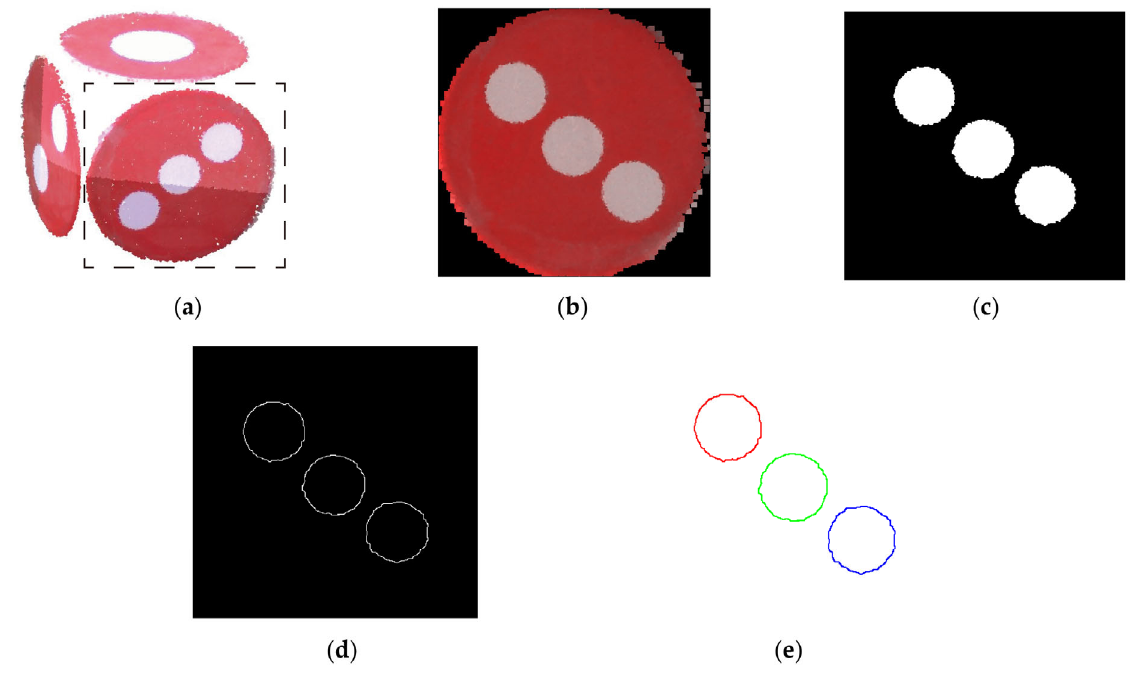
Figure 6. Key steps of the pips recognition for individual facets. ( a ) Dice plane division. ( b ) Rasterization and raster image convolution. ( c ) Raster image binarization. ( d ) Canny edge detection. ( e ) DBSCAN circle clustering.